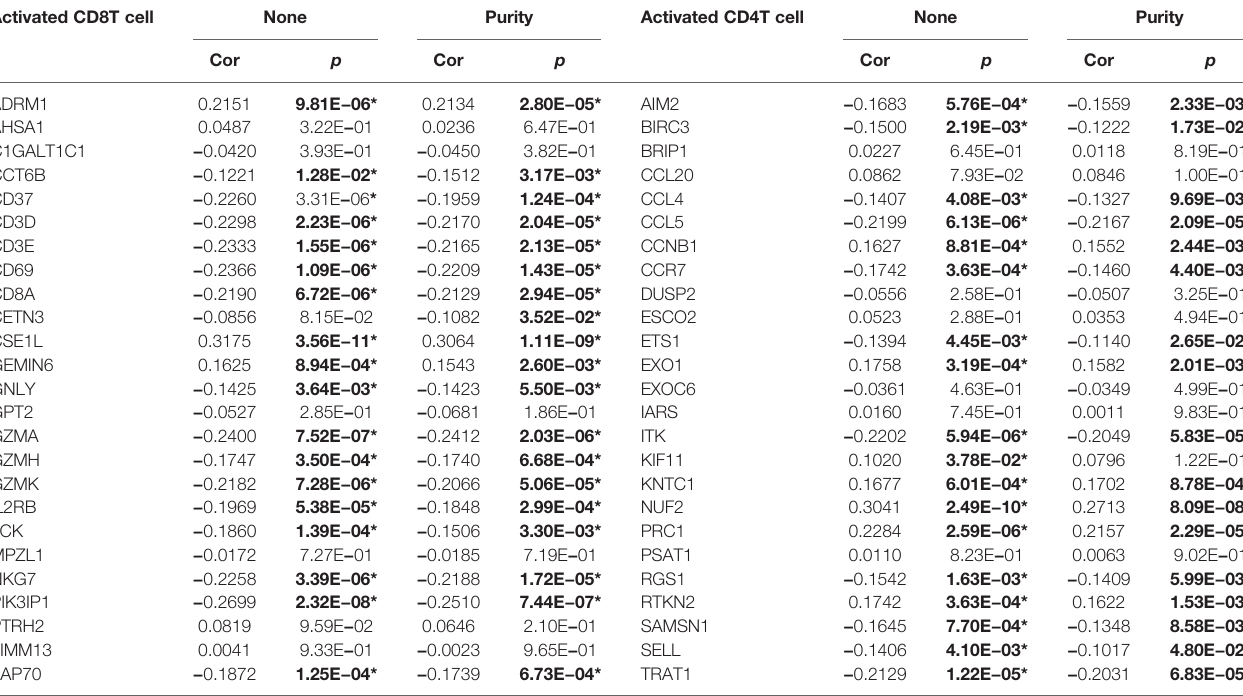
TABLE 1 | Correlation analysis between MAGEA3 and markers of active T cells. Activated CD8T cell None Purity Activated CD4T cell None Purity